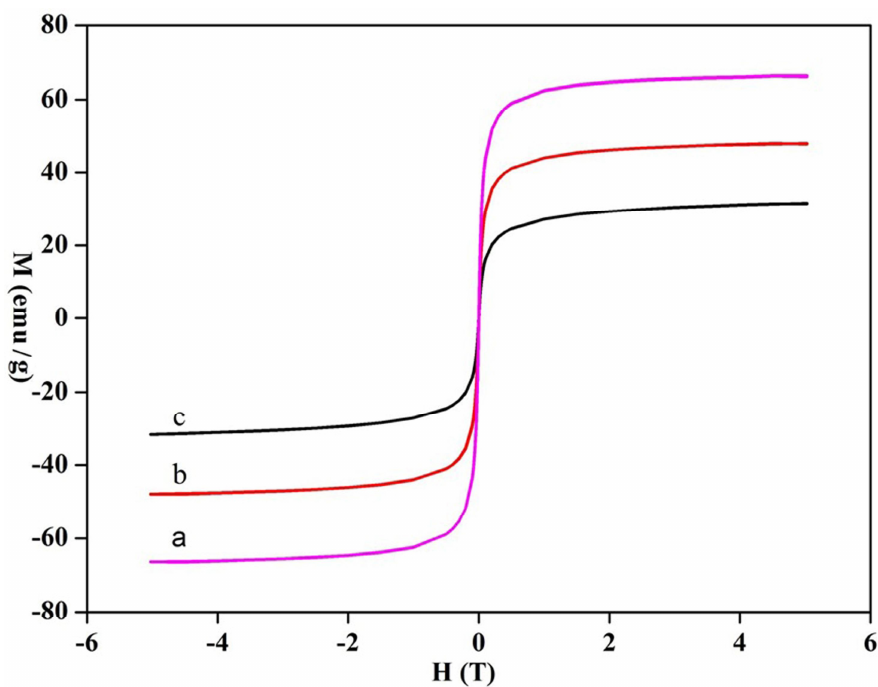
Fig. 4. Hysteresis loops of a) Fe